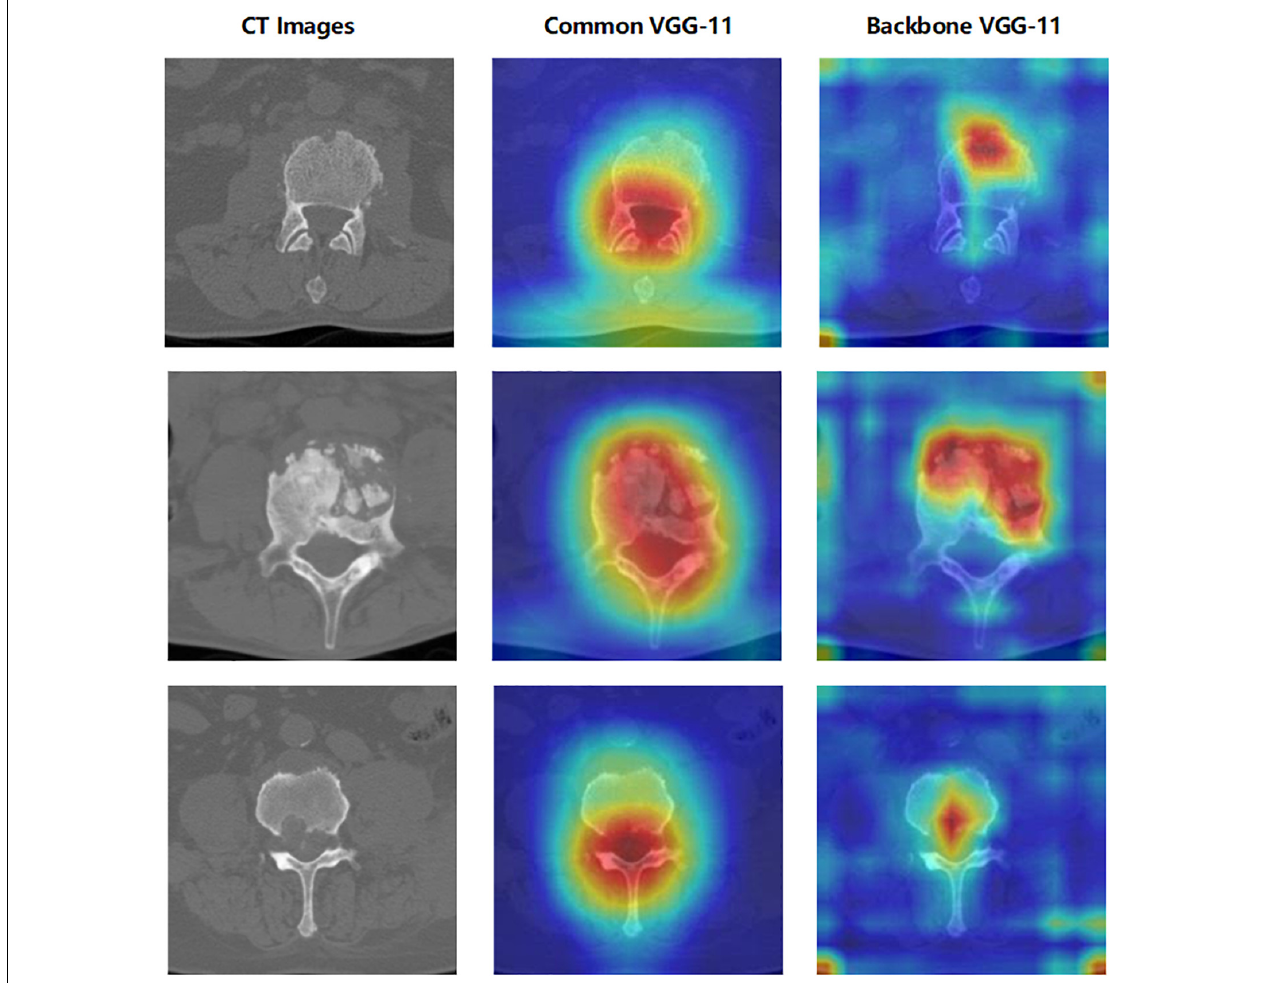
FIGURE 13 | Heatmap of the convolution layer weight visualization based on Grad-CAM++. The left column contains the original CT images, the middle column contains the heatmap generated by common VGG-11, and the right column contains the heatmap generated by backbone VGG-11 of the proposed